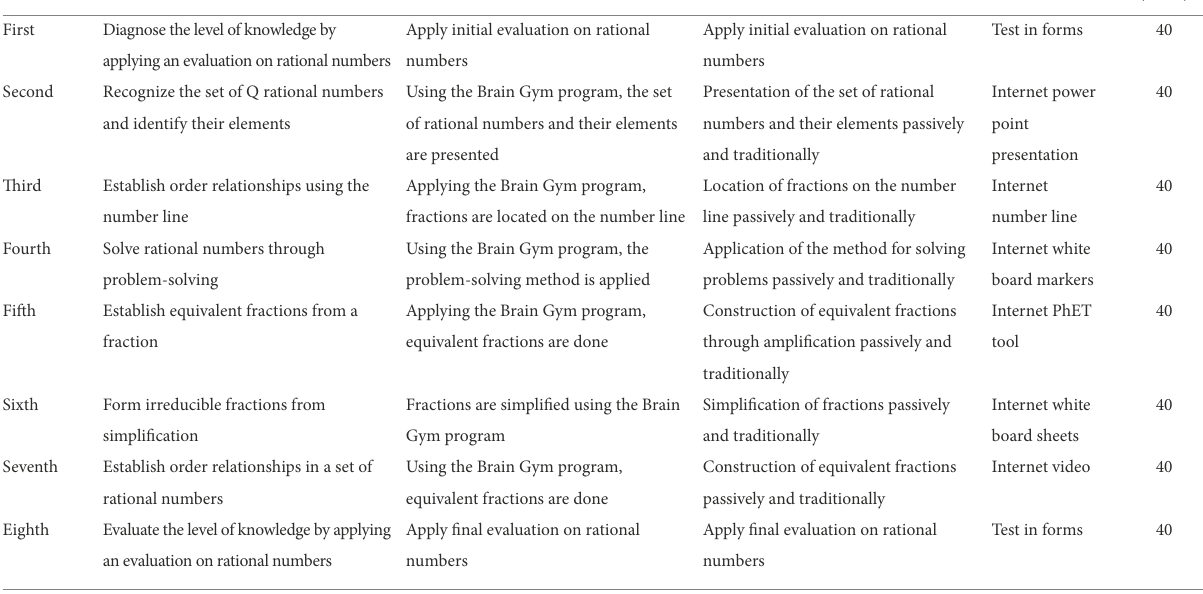
TABLE 1 Brain Gym intervention